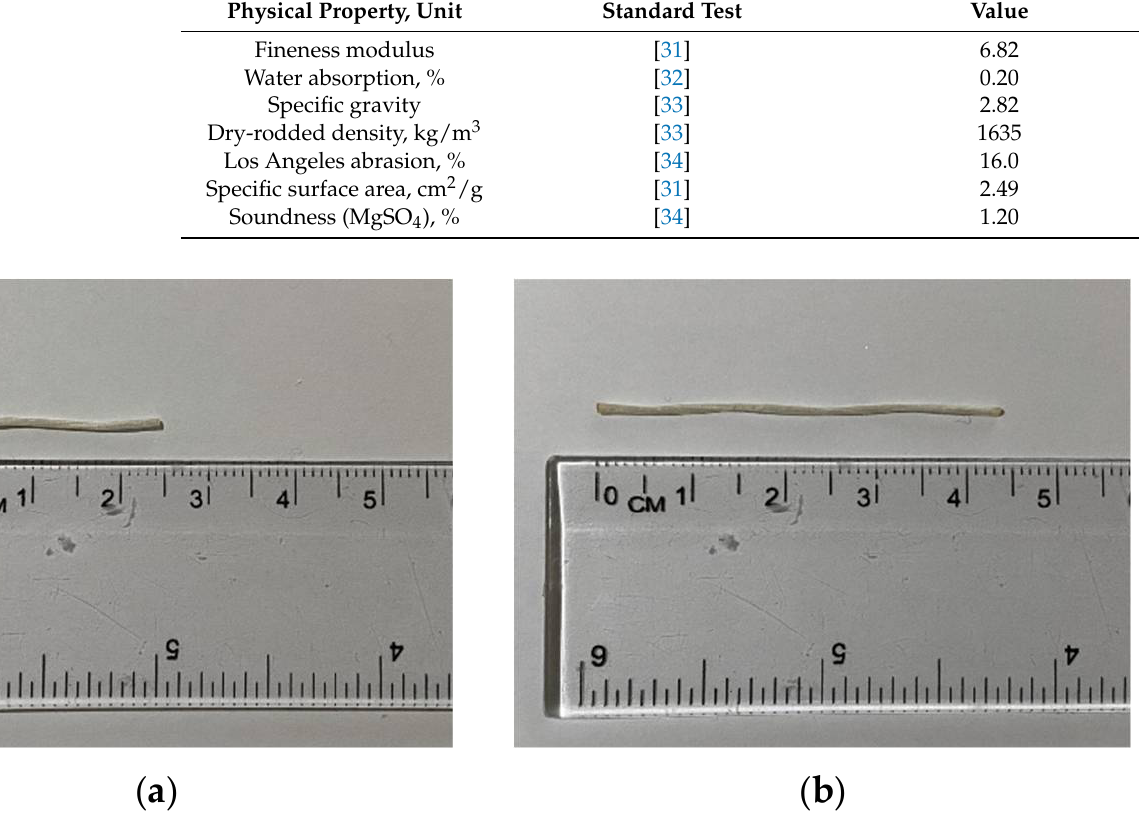
Figure 5. Glass fibers with lengths of ( a ) 24 and ( b ) 43 mm. Table 3. Properties of the glass fibers.